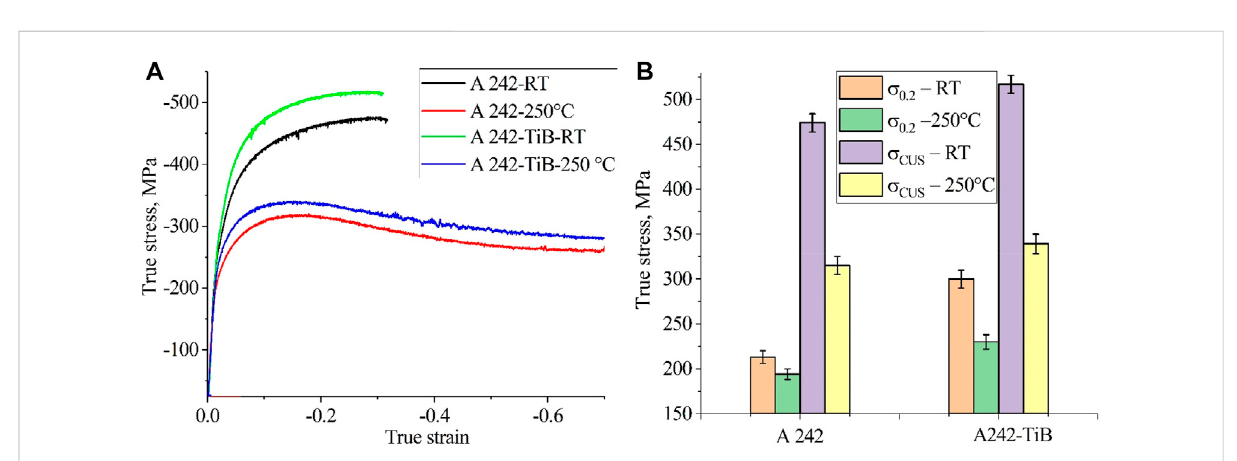
Mechanical properties, (A) Stress-strain diagram, (B) Ultimate compression stress.